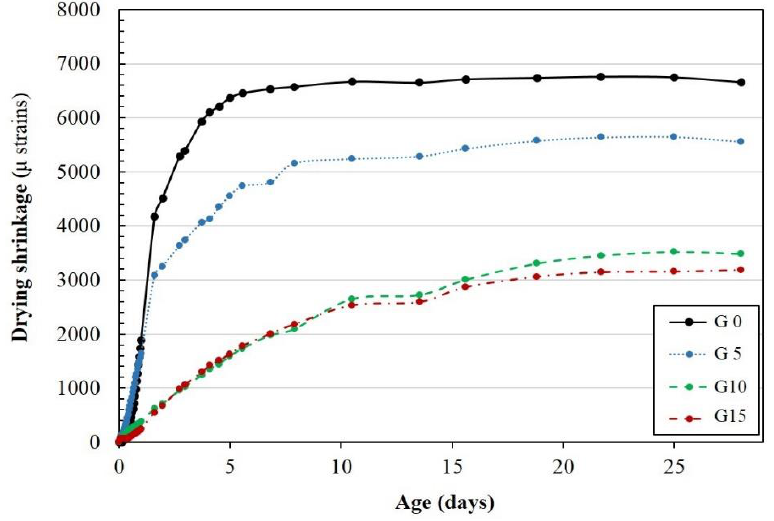
Figure 1. Drying shrinkage of the specimens.